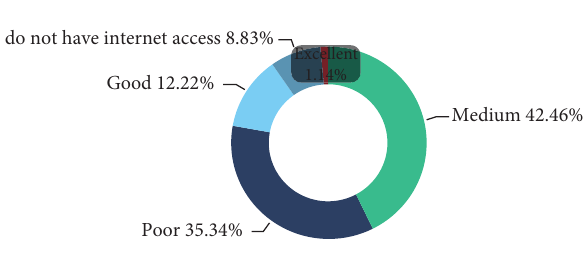
Figure 5: Internet connection